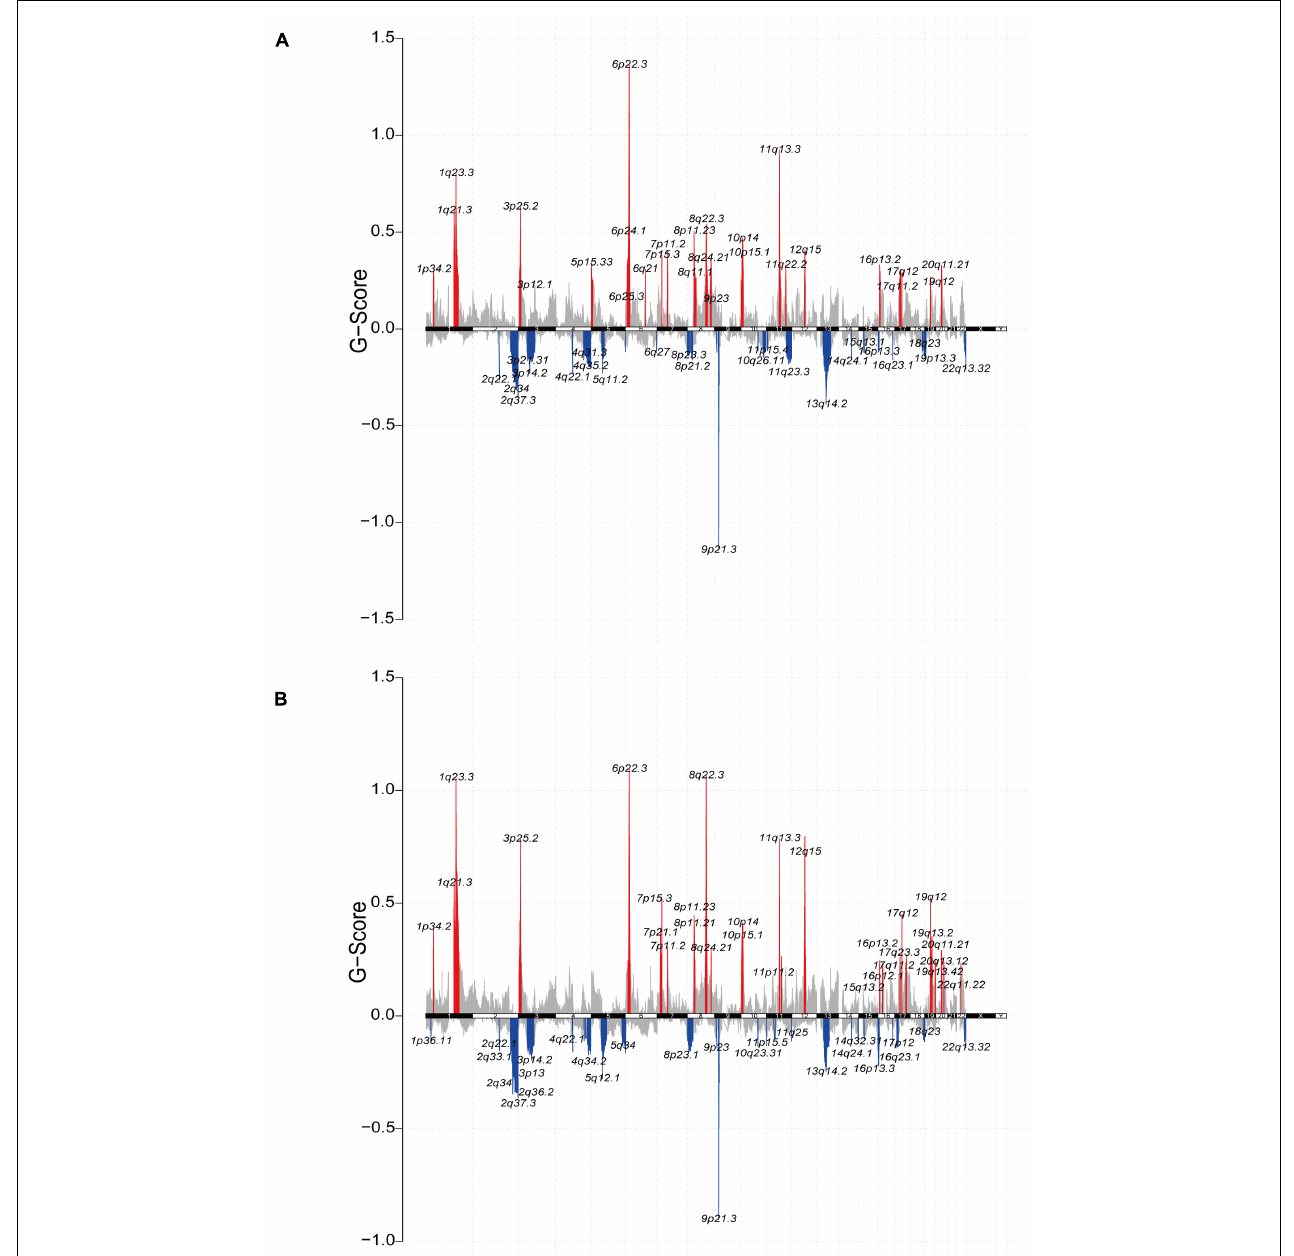
FIGURE 6 | The relationship between the ICI score and copy number variation in the TCGA-BLCA cohort. (A,B) The visualization of the copy number variation analysis based on GISTIC2.0 for high (A) and low (B) ICI score groups.